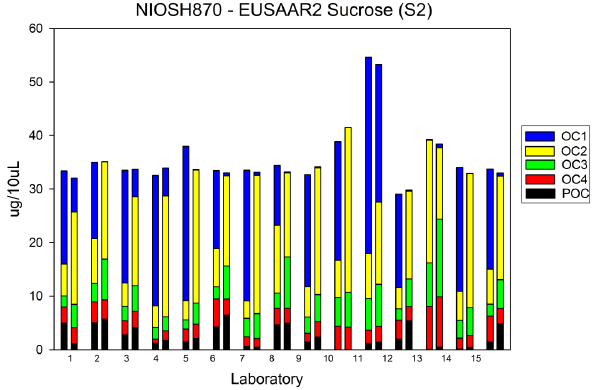
Figure 10. Laser transmittance signal during filter sample A analy- sis with the use of NIOSH870 thermal protocol for all laboratories.